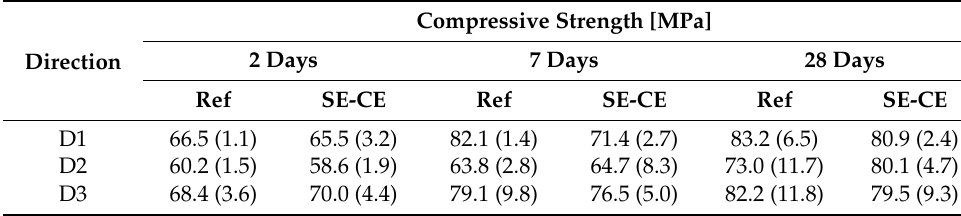
Table 2. Ultimate compressive strength of printed SHCC tested in different directions.